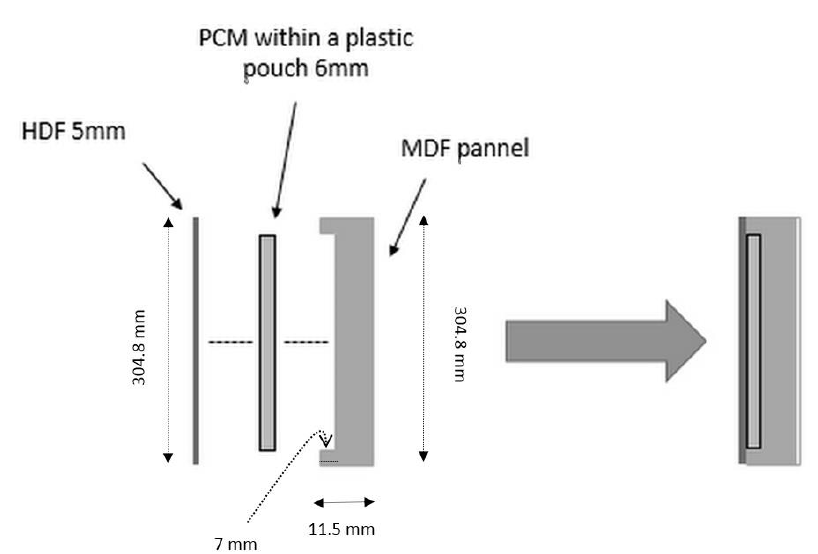
Figure 1. Sketch of a wood-based PCM panel [54].